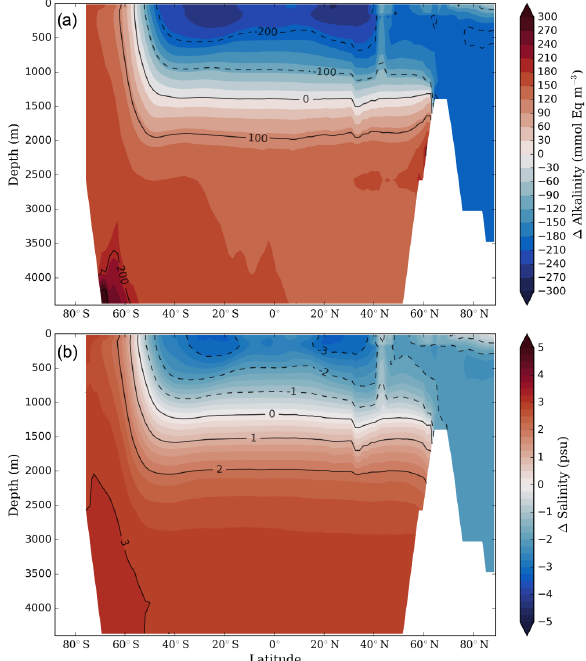
Figure 6. Change in the zonally averaged global distribution of (a) alkalinity (mmolEqm − 3 ) and (b) salinity (PSU) between the O- LGM and O-PI experiments (O-LGM − O-PI). Despite the strong re- duction in salinity in the upper ocean of the O-LGM experiment rel- ative to O-PI, the whole-ocean salt content was greater by